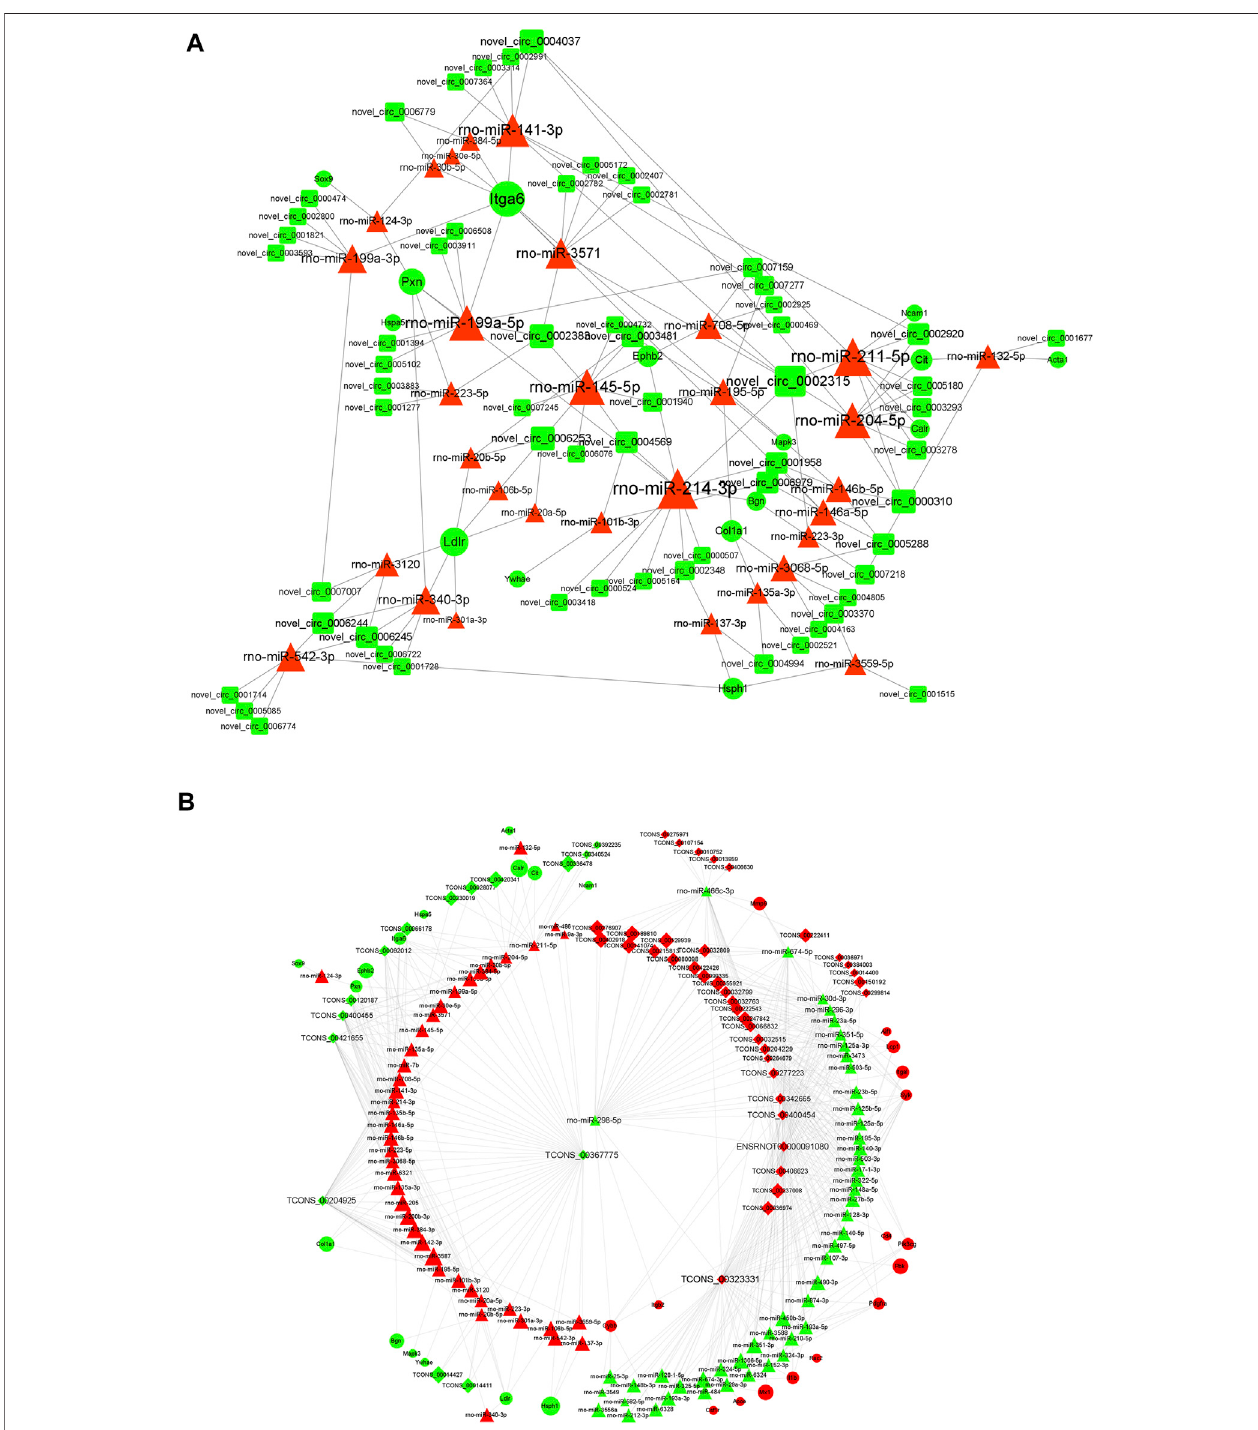
FIGURE 8 | ceRNA interaction network of circRNA and lncRNA. (A) Competing endogenous RNA (ceRNA) interaction network of circRNA-miRNA-mRNA. (B) Competing endogenous RNA (ceRNA) interaction network of lncRNA-miRNA-mRNA. Red represents upregulated expression, whereas green represents downregulatedexpression. Roundrectanglenodes represent circRNAs, trianglenodes represent miRNAs,and ellipsenodes represent mRNAs.circRNA, circularRNA; lncRNA, long non-coding RNA; miRNA/miR, microRNA; mRNA, messenger RNA; FC, fold change.